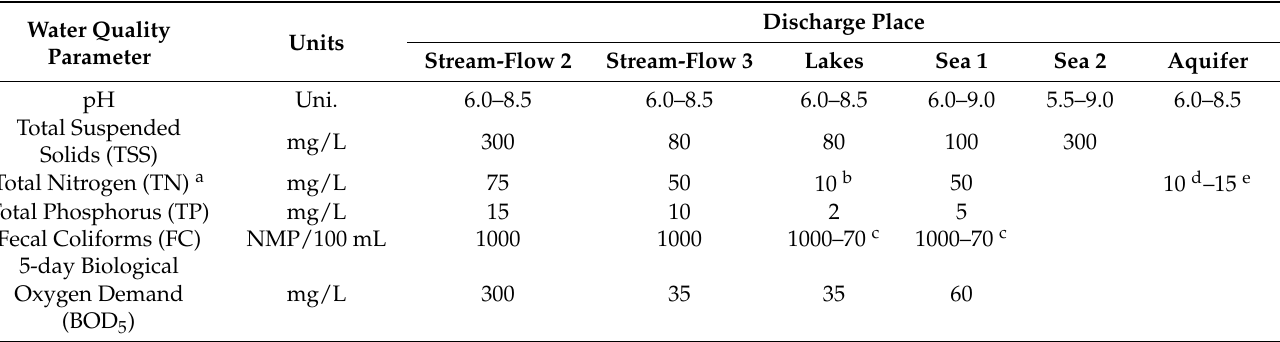
Table 3. Selected water quality standards include in Chilean regulations for discharge (DS 90 [77] and DS 46 [75]. (Modified from Vera et al.